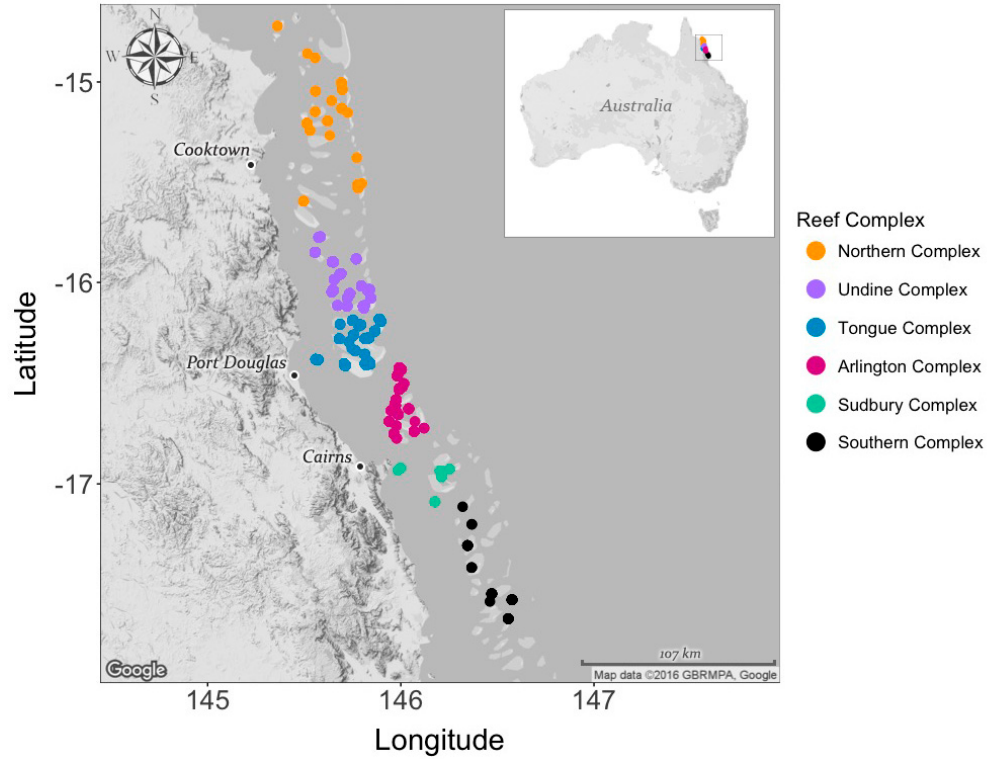
Figure 1. Map of the north Queensland coast showing the sampling locations ( n = 111) and designated reef complexes ( n = 6) for the collection of 0+ year crown-of-thorns